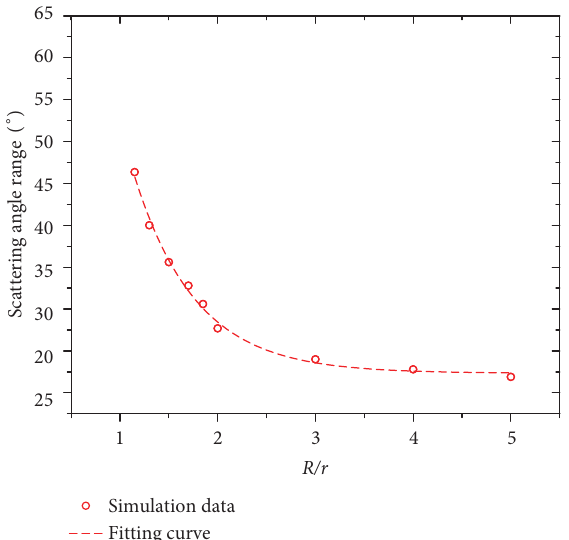
Figure 13: The fitting curve of curvature and projection angle